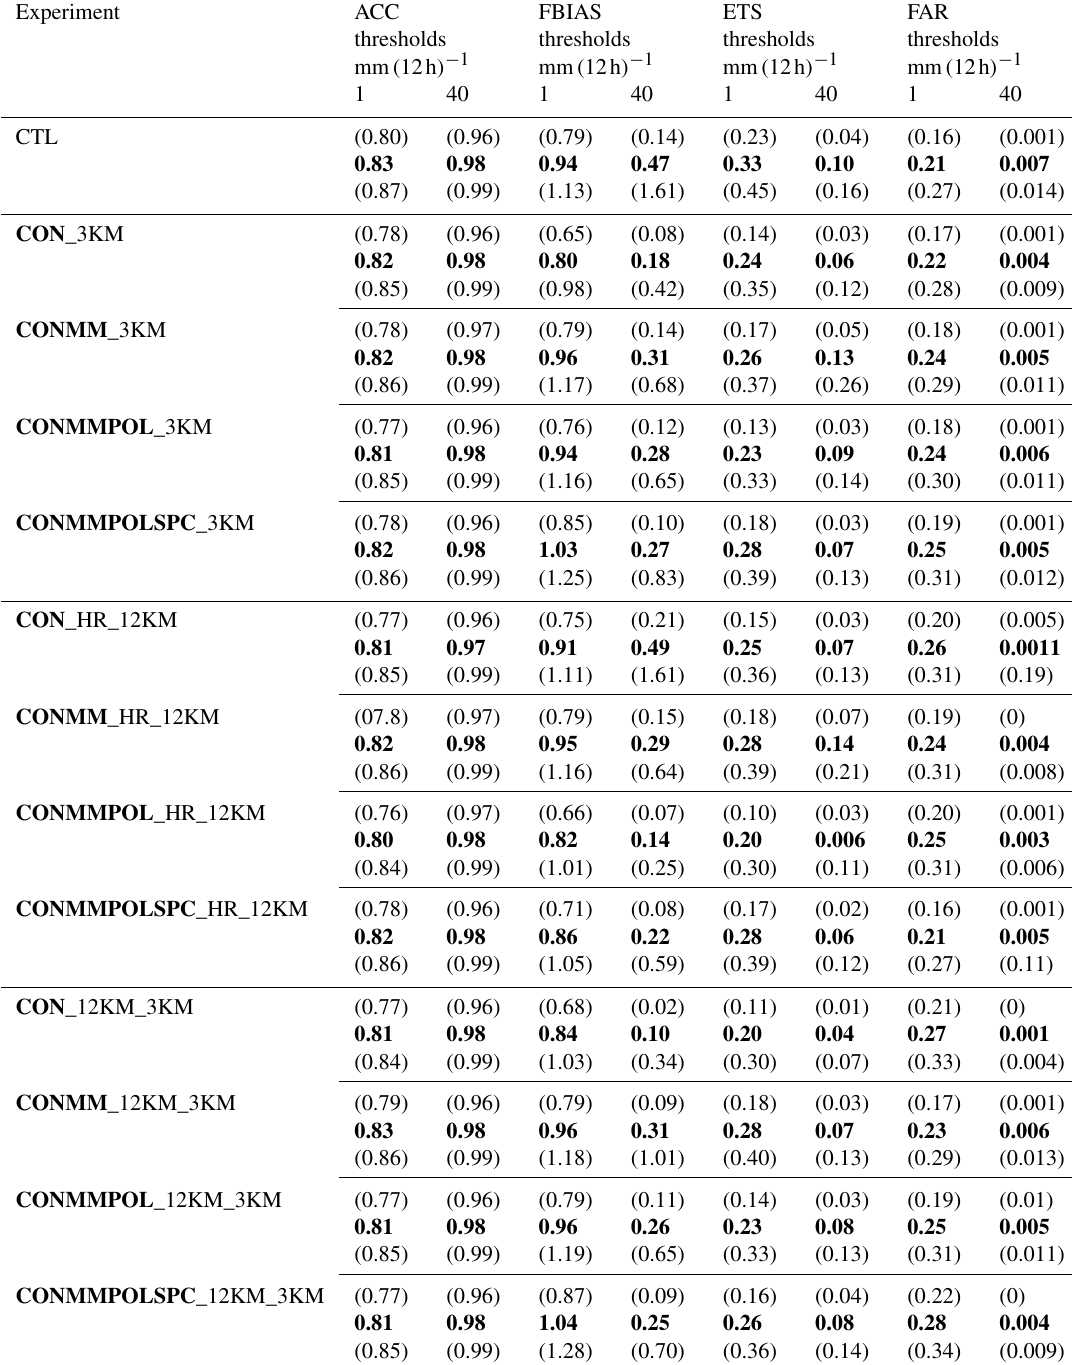
Table 4. Bootstrap 95% confidence intervals for verification statistics forecast accuracy (ACC), frequency bias (FBIAS), equitable threat score (ETS), false alarm ratio (FAR), and referring to experiments in lines 1–4 of Fig. 7. They are considered as a function of thresholds (1 and 40mm ( 12h ) − 1 ). The experiments are CTL, CON_3KM/CONMM_3KM/CONMMPOL_3KM/CONMMPOLSPC_3KM, CON_HR_12KM/CONMM_HR_12KM/CONMMPOL_HR_12KM/CONMMPOLSPC_12KM, CON_12KM_3KM/CONMM_12KM_3KM/CONMMPOL_12KM_3KM/CONMMPOLSPC_12KM_3KM. The numbers in bold font rep- resent the value between bootstrap upper and lower confidence